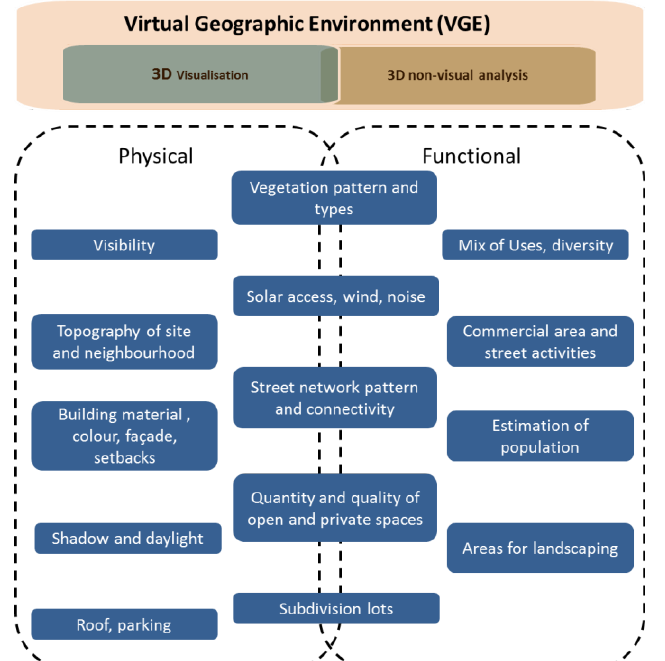
Figure 3. Measuring and visualising objective aspects of building and neighbourhood using 3D spatial technology in a virtual geographic